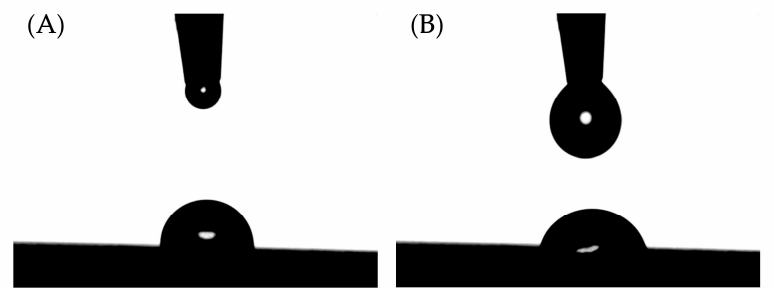
Figure 3. Photograph of the initial ( A ) and equilibrium ( B ) contact angle of glycerin (Sample 4#).